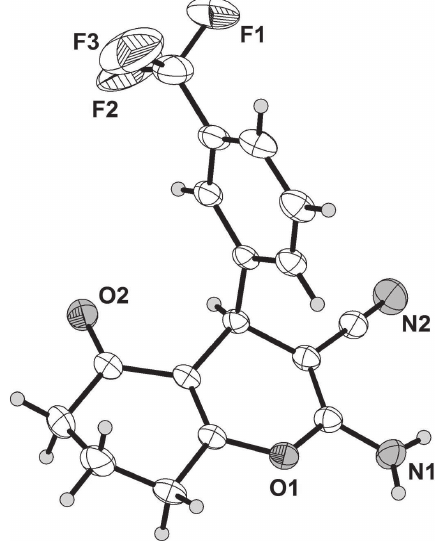
Table 1: Data collection and handling.